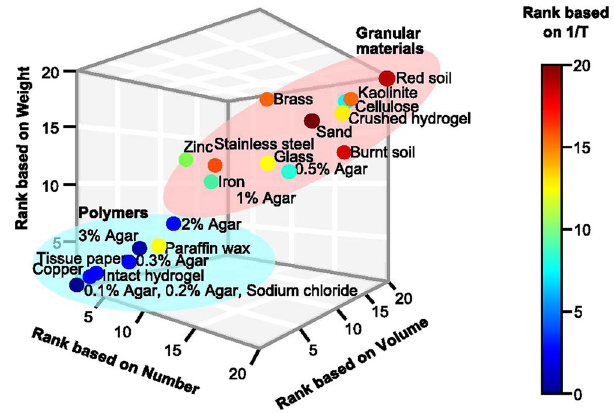
Figure 4. Combined ranking of materials by individuals of both castes based on four criteria. 1/T represents 1/ Time taken to start making boluses; Number represents total number of boluses made in 20 minutes; Volume represents total volume of boluses made in 20 minutes, and Weight represents total weight of boluses carried in 20